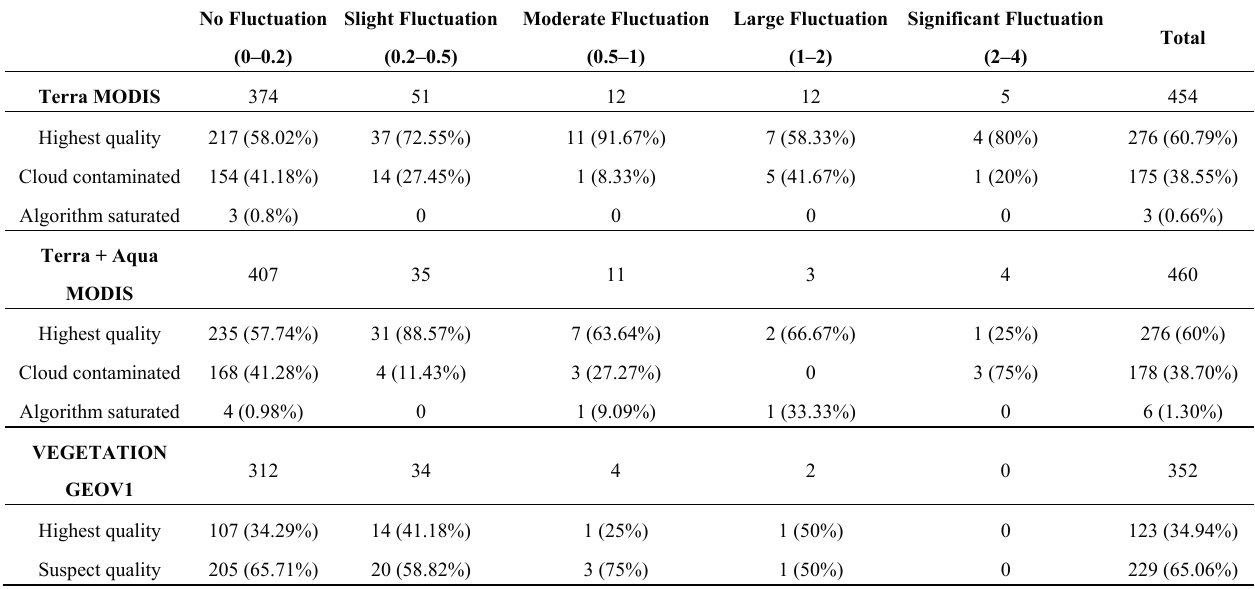
Table 5. Statistical pixel distribution from the LAI products curve